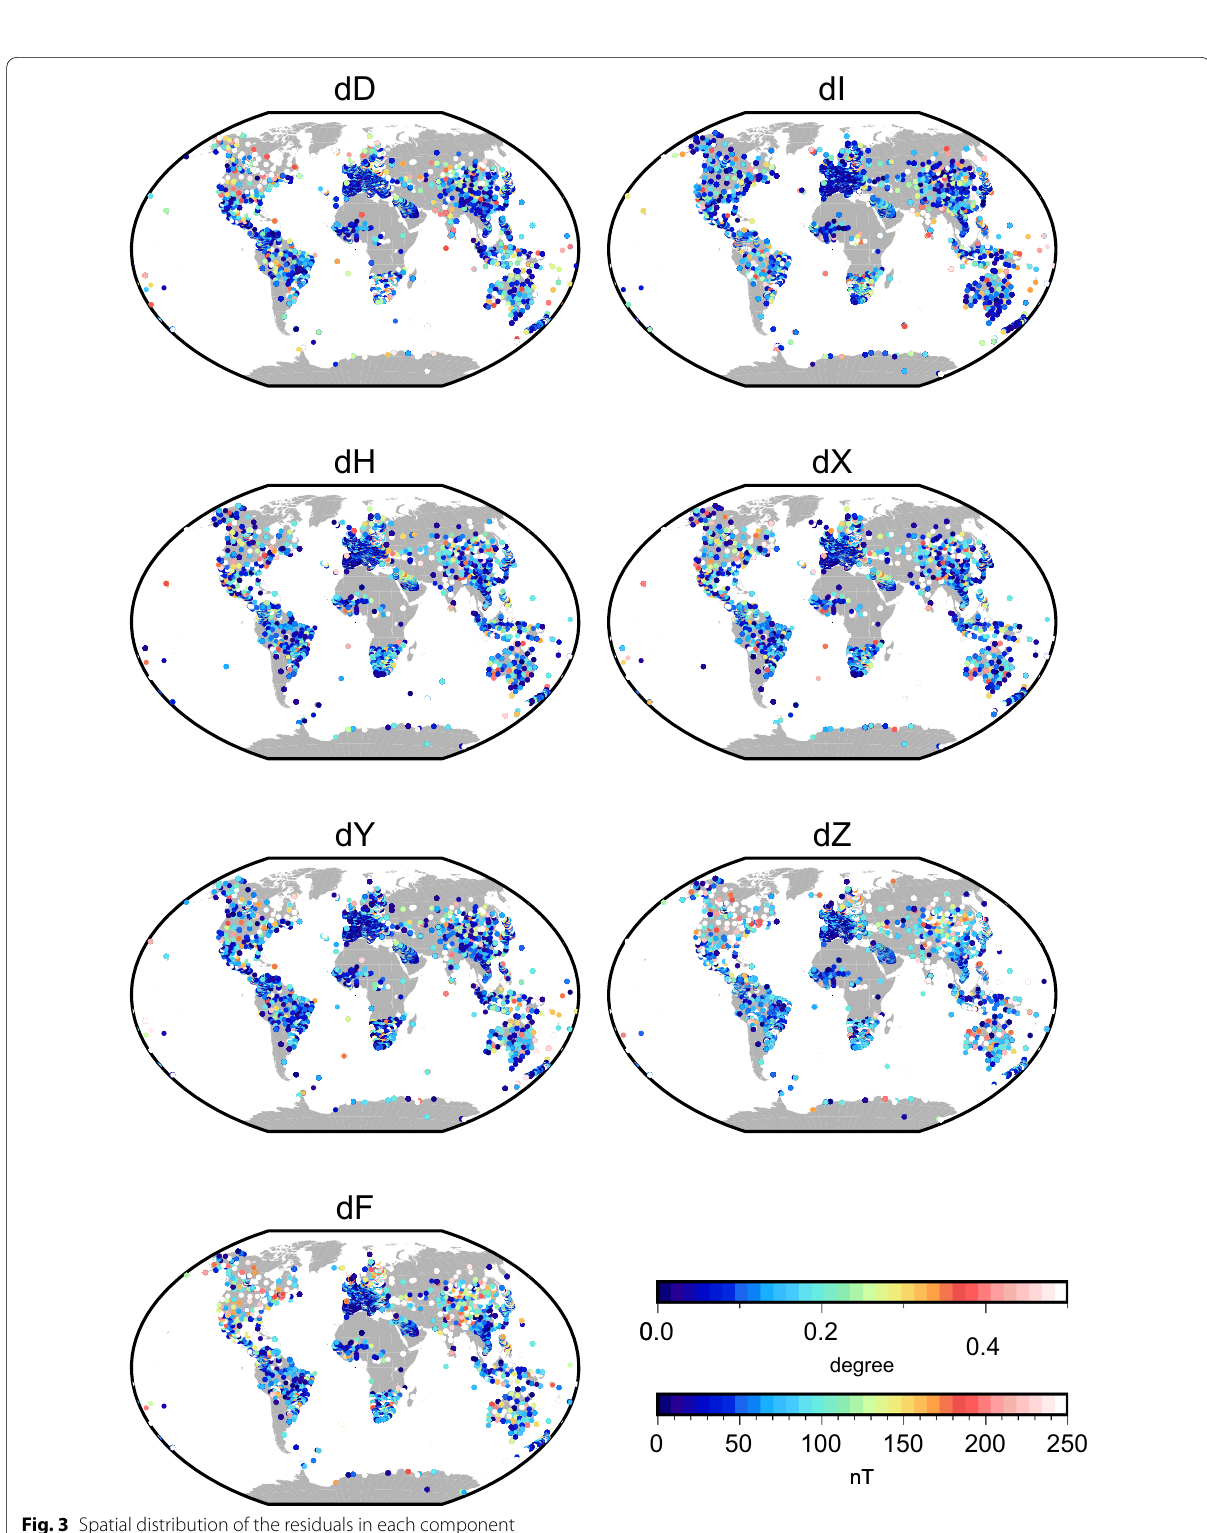
Fig. 3 Spatial distribution of the residuals in each